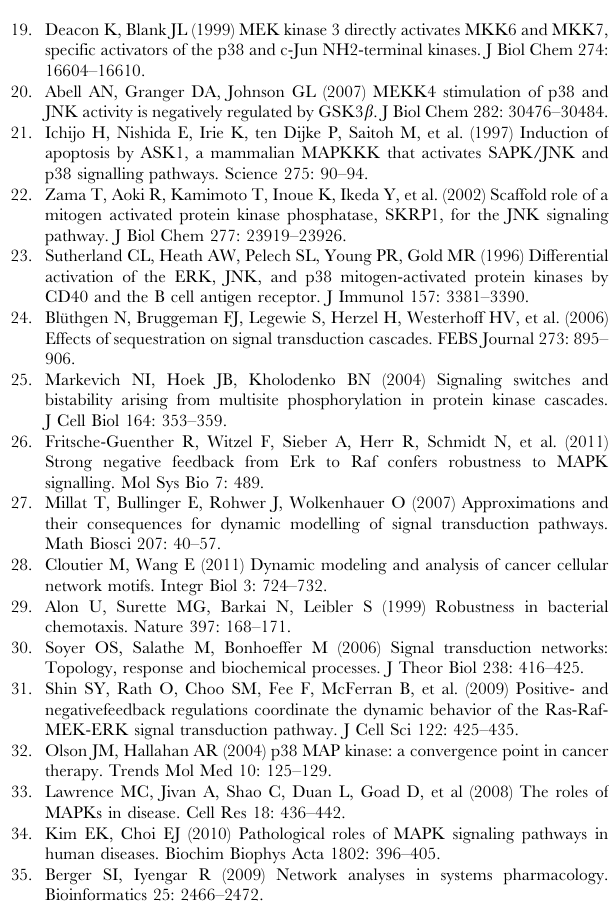
Figure S2 Role of asymmetry for reaction parameters at a given branch (the corresponding values for the other branch in the two branches. Relative increase of response as a function are taken to be the same) are randomly chosen from uniform of the signal on blocking MAPK A activation when (A) the product distributions bounded between physiologically plausible minimum and k A ) are 5 times higher than formation rates for branch A ( k A and maximum values for the parameters that are given in Table 4 6 those in branch B and (B) the product formation rates for branch B S1. (TIF) and k B ) are 5 times higher than those in branch A; (C) the ( k B 4 6 binding reaction rates for branch A ( kp A and kp A ) are 10 times Table S1 Parameter values for reactant total concen- 5 3 higher than those in branch B; (D) the binding reaction rates for trations and reaction rates used in the model simula- and kp B ) are 10 times higher than those in branch branch B ( kp B tion. The same values for the corresponding parameters are used 5 3 A; (E) the total concentrations of phosphatase of MAP2K* and in the different branches. MAP2K** of branch A are 10 times larger than the corresponding (XLS) values for branch B (= mean value in the Huang-Ferrell range) Text S1 Equations describing the dynamics of the and (F) the total concentrations of phosphatase of MAP2K* and model system with two branches. MAP2K** of branch B are 10 times larger than the corresponding values for branch A (= mean value in the Huang-Ferrell range). (TIF) Figure S3 Robustness of the effect of retrograde propagation in branched motifs with respect to param- eter variation. The variation in the relative increase in response, i.e., concentrations of MAPK B ** and MAP2K B ** on blocking the phosphorylation of MAPK A , measured in terms of Total Parameter Variation (TPV) on randomly varying the 38 parameters in the model. The dots in each figure indicate the individual values obtained from 10 4 realizations for three different signal strengths: (a–b) [S 0 ] = 10 2 12 M, (c–d) [S 0 ] = 10 2 10 M and (e–f) [S 0 ]= 10 2 8 M. The 38 parameters, which include total concentrations and reaction rates for all kinases and phosphatases